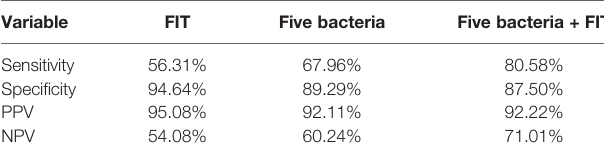
TABLE 2 | Performance of FIT alone, combined with fi ve bacteria to diagnose colorectal cancer in cohort I.